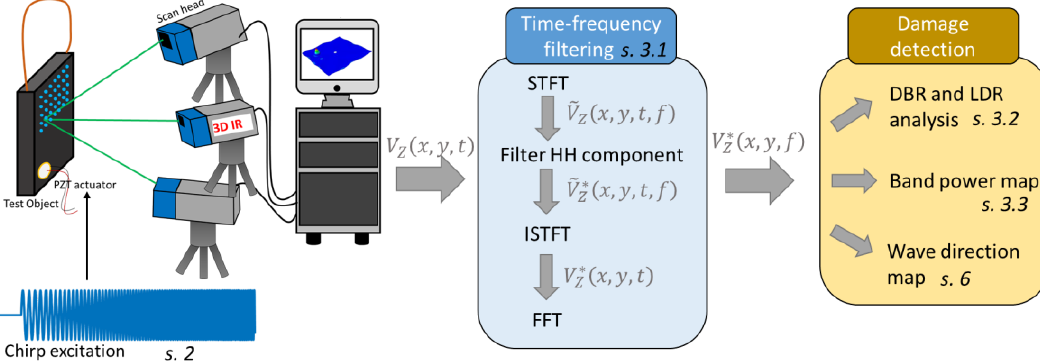
Figure 1. Schematic overview of all steps in the damage detection procedure.